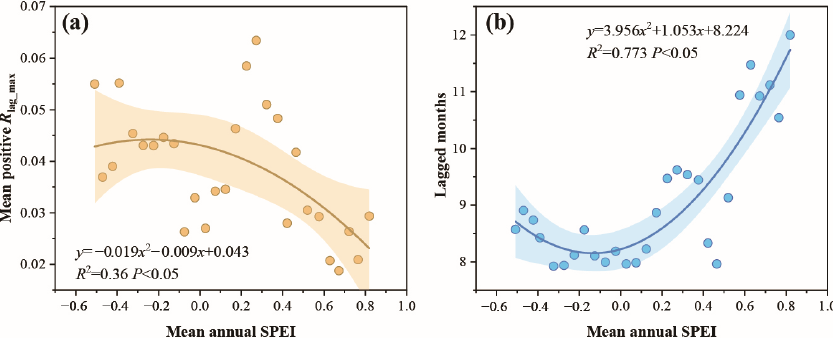
Figure 16. ( a ) Relationships between mean annual SPEI and positive R max_lag . ( b ) Relationships between mean annual SPEI and lagged months.